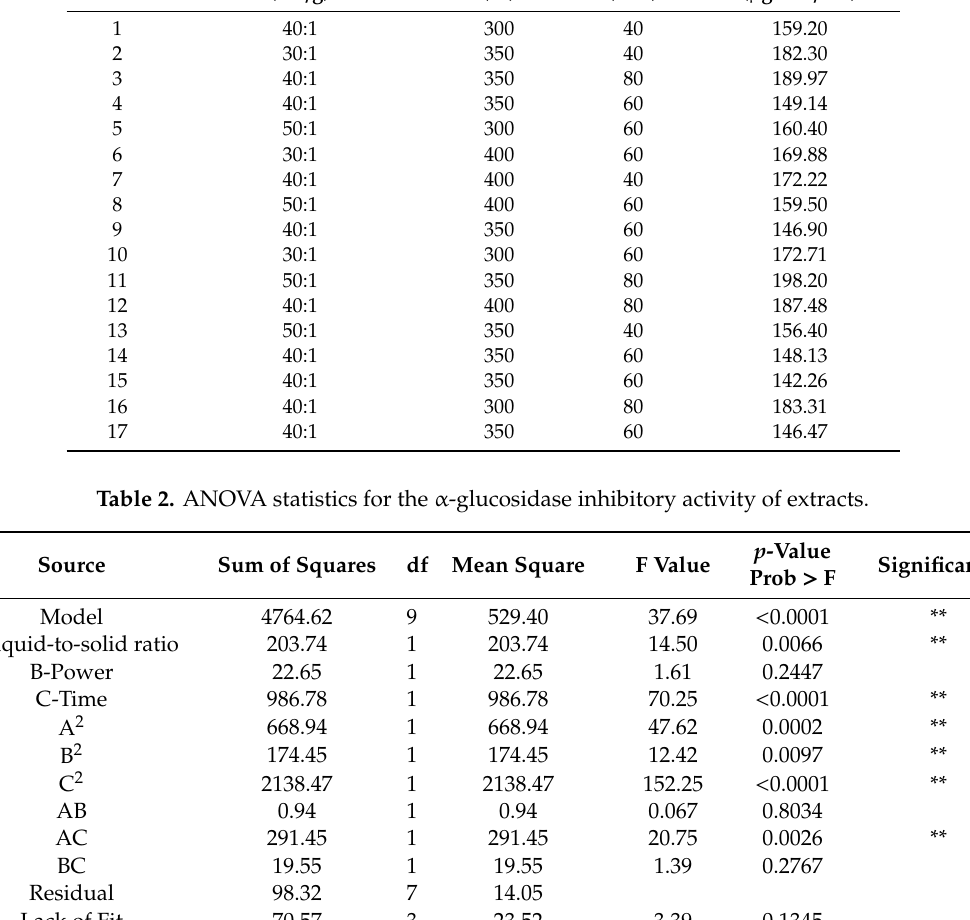
Table 1. Box—Behnken design for extraction of α -glucosidase inhibitors (AGIs) from CDL by ultrasonic-assisted extraction (UAE) with the observed responses.